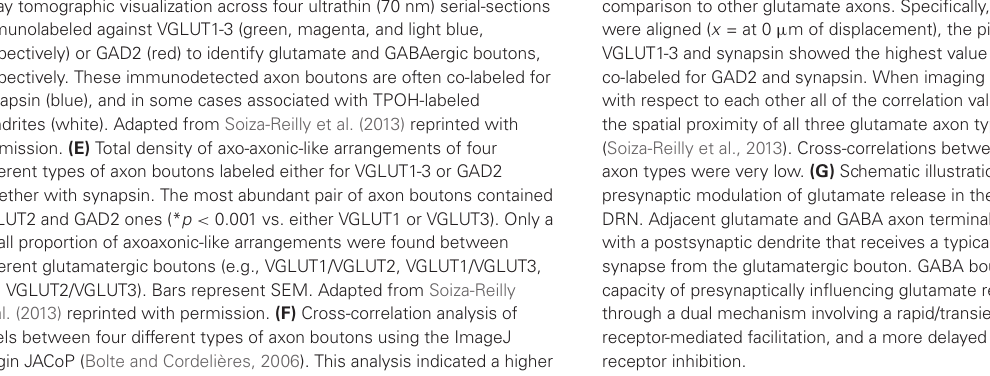
FIGURE 3 | Glutamate and GABA axon boutons in the DRN. (A–D) Array tomographic visualization across four ultrathin (70 nm) serial-sections immunolabeled against VGLUT1-3 (green, magenta, and light blue, respectively) or GAD2 (red) to identify glutamate and GABAergic boutons, respectively. These immunodetected axon boutons are often co-labeled for synapsin (blue), and in some cases associated with TPOH-labeled dendrites (white). Adapted from Soiza-Reilly et al. (2013) reprinted with permission. (E) Total density of axo-axonic-like arrangements of four different types of axon boutons labeled either for VGLUT1-3 or GAD2 together with synapsin. The most abundant pair of axon boutons contained VGLUT2 and GAD2 ones (* p < 0.001 vs. either VGLUT1 or VGLUT3). Only a small proportion of axoaxonic-like arrangements were found between different glutamatergic boutons (e.g., VGLUT1/VGLUT2, VGLUT1/VGLUT3, and VGLUT2/VGLUT3). Bars represent SEM. Adapted from Soiza-Reilly et al. (2013) reprinted with permission. (F) Cross-correlation analysis of pixels between four different types of axon boutons using the ImageJ plugin JACoP (Bolte and Cordelières, 2006). This analysis indicated a higher